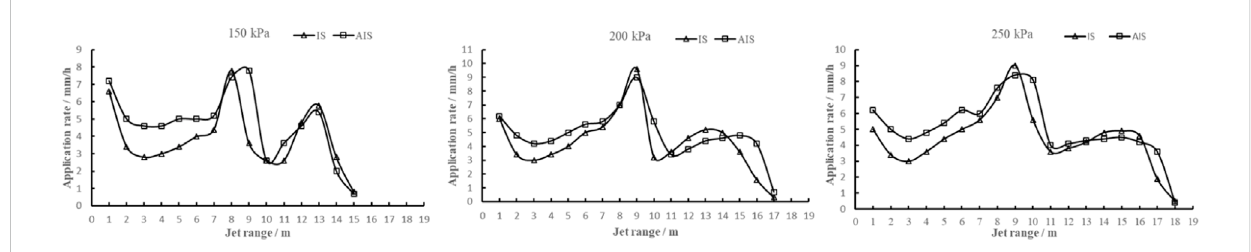
FIGURE 5 Radial water distribution curve between the AIS and the IS with different pressure. AIS, aeration impact sprinkler; IS, impact